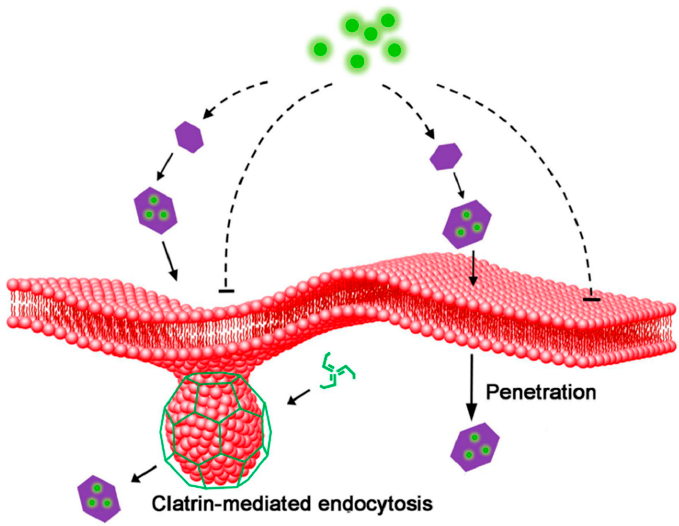
Figure 16. Mechanisms of LDH-lactate internalization (clathrin-mediated endocytosis) for molecule delivery into plant cells. Figure reproduced from Ref. [224] under the terms of the Creative Commons Attribution Non-Commercial License.